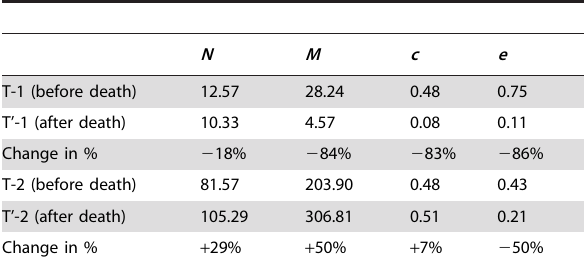
Table 2. Almost all the parameter changes of individual egocentric networks after the sudden death of superstars fall in range of the parameter changes due to normal evolution of the collaboration networks.